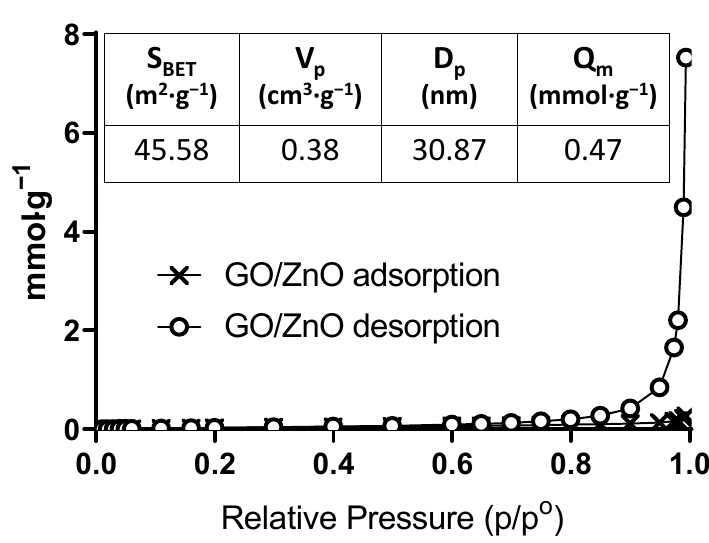
Figure 2. BET adsorption–desorption isotherms for ZnO NPs.